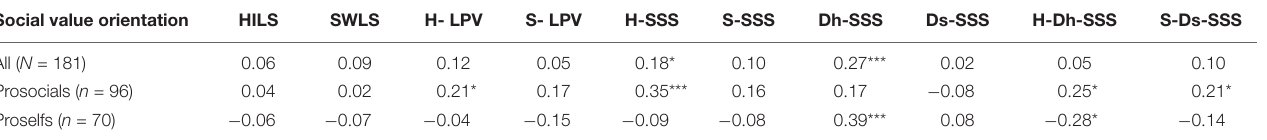
TABLE 3 | Spearman’s rho for self-reports and cooperation for the various